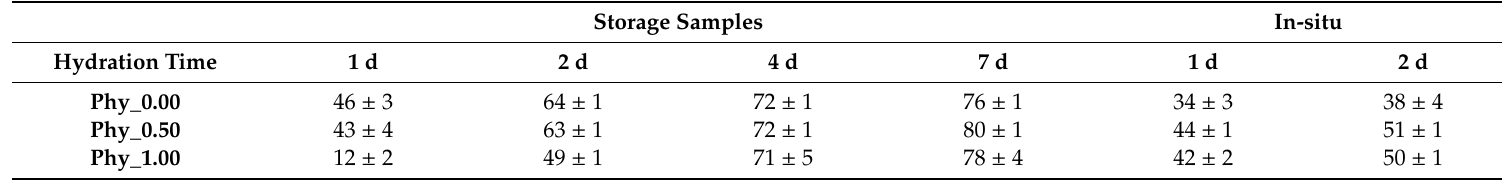
Table 5. The degree of hydration of samples composed of α –TCP and CDHA (weight ratio 9:1) with di ff erent amounts of sodium phytate after 1 d, 2 d, 4 d and 7 d of